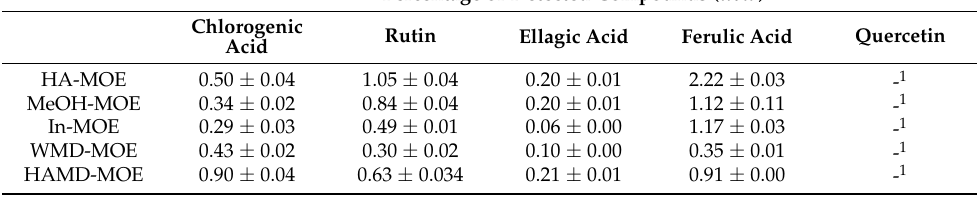
Table 3. Percentages of chlorogenic acid, rutin, ellagic acid, ferulic acid, and quercetin in the five different dried extracts of M. oleifera Lam. leaves. Each value was obtained from three analyses (mean ± SD).